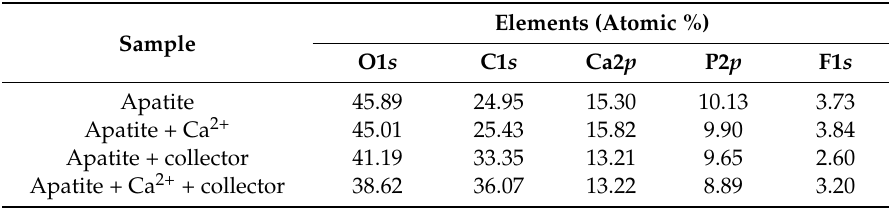
Table 2. Atomic percent of elements for apatite surfaces in various conditions (pH = 7.0).